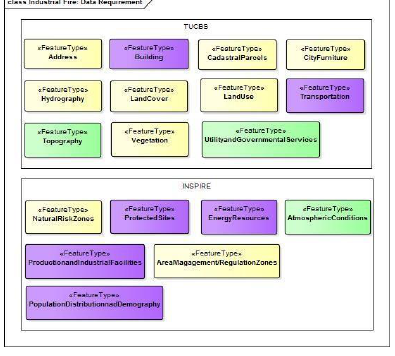
Figure 10: 3D geo-information requirements diagram for industrial fire